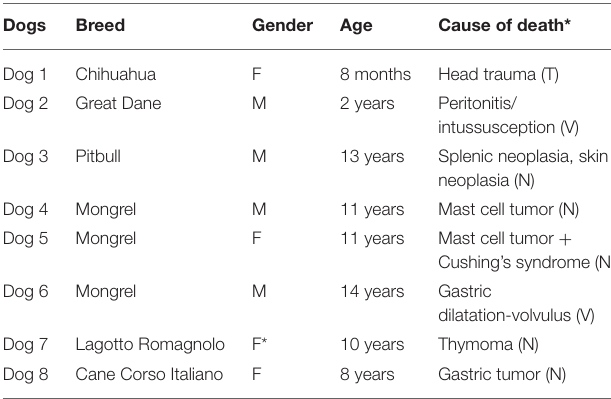
TABLE 1 | Clinico-pathological data of the dogs included in the present